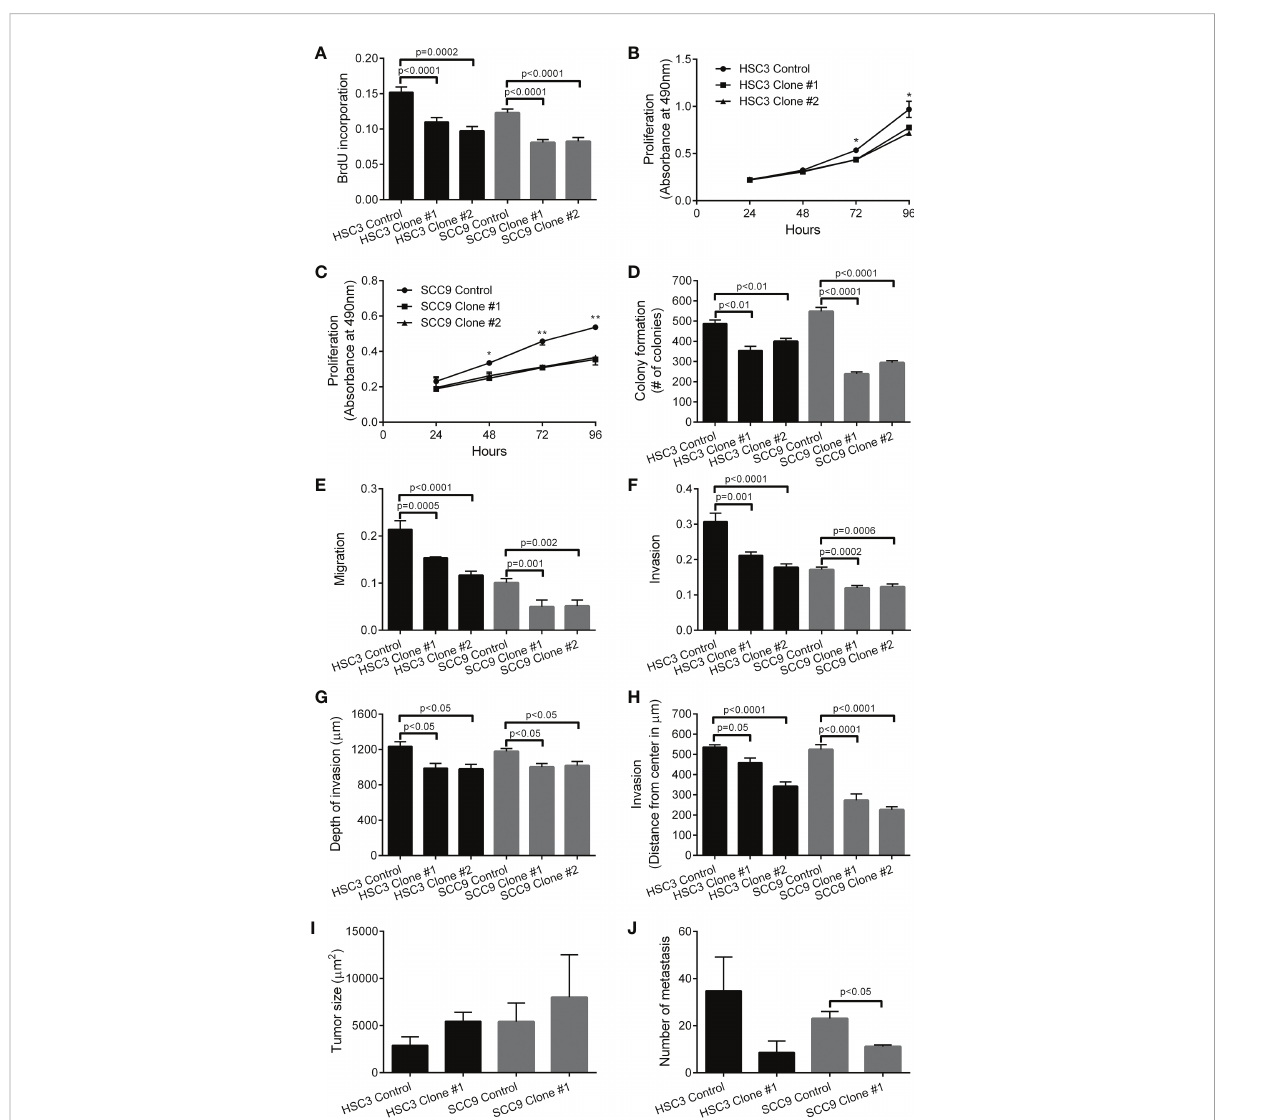
FIGURE 3 Knockdown of STIP1 controls proliferation, migration, invasion and metastasis. Downregulation of STIP1 signi fi cantly inhibited the proliferative potential of HSC3 and SCC9 cells, as revealed BrdU incorporation index (A) , growth curves (B, C) and number of colonies in the colony formation assay (D) . Migration (E) and Invasion (F) of HSC3 and SCC9 cells were signi fi cantly decreased by STIP1-speci fi c shRNAs, as revealed by transwell-based assays. The impaired invasion of both HSC3 and SCC9 cells after STIP1 knockdown was observed in the organotypic myoma assay (G) , represented by low depth of invasion, and in the 3D spheroid assays (H) . In the zebra fi sh model, no signi fi cant differences in volume of tumors formed by HSC3 and SCC9 cells with STIP1 knockdown or controls were observed (I) , but the number of metastatic foci were decreased in STIP1 silenced cells, reaching signi fi cant levels for SCC9 cells (J) . The values represent the average ± SD of three separate experiments. In the organotypic myoma assay, three deepest islands were measured in four microscopic fi elds of six myomas. In a zebra fi sh model, n=16-21 in three independent experiments. *p<0.05,